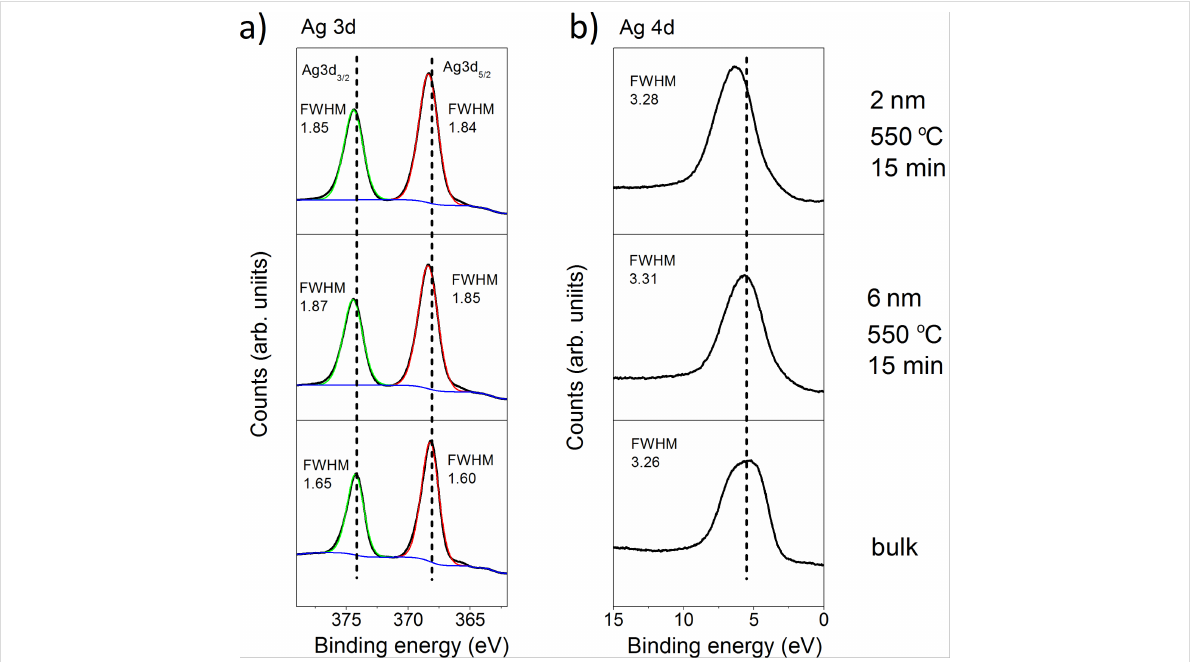
Figure 12: (a) Ag 3d and (b) Ag 4d XPS spectra of bulk Ag and Ag nanostructures grown after annealing of 2 nm and 6 nm thin films at 550 °C for 15 min.